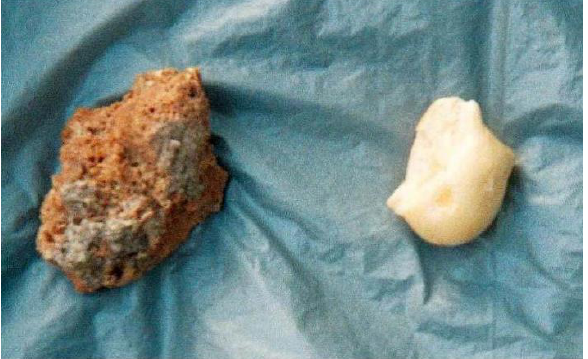
Figure 20. Polyurethane product used to close the vortex